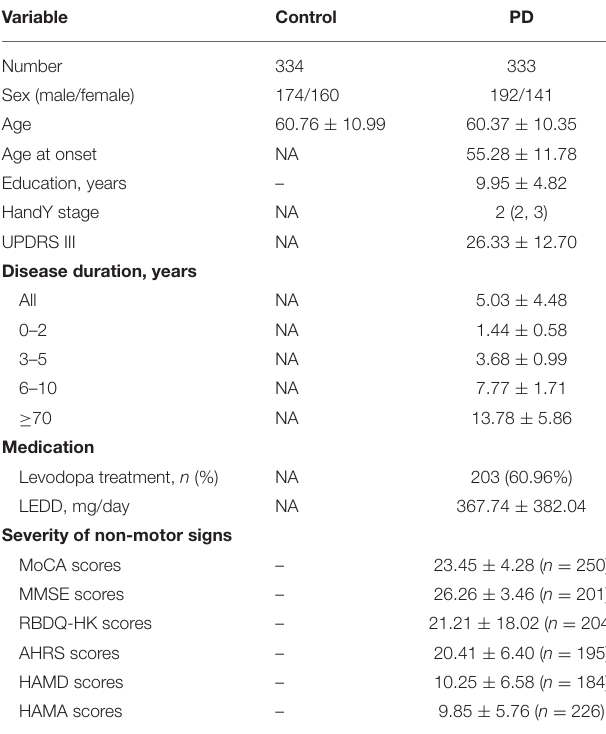
TABLE 1 | Demographic data of the study